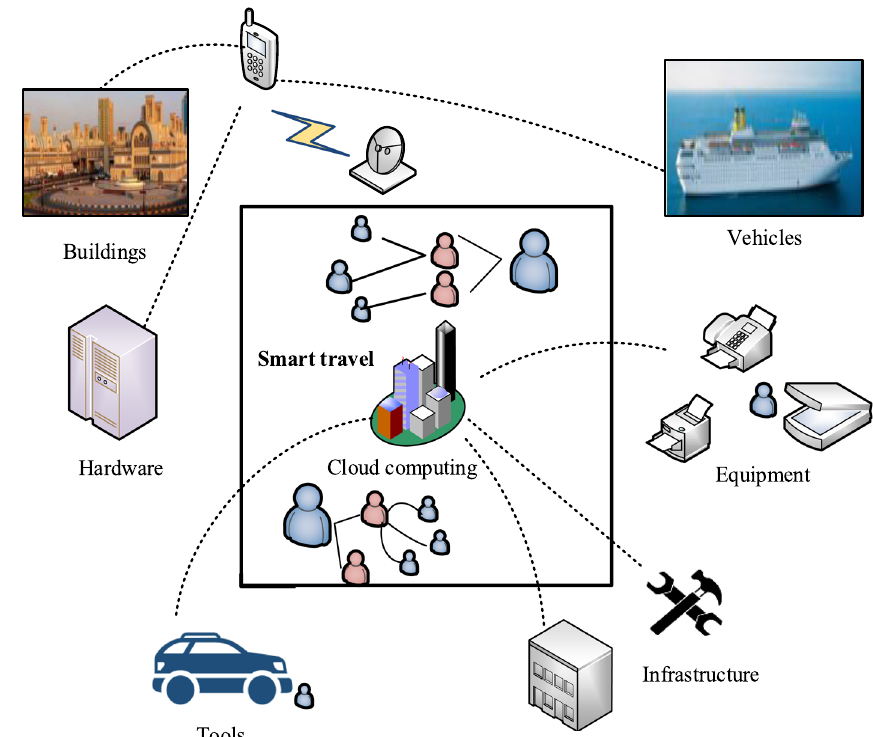
Fig. 3 Implementation of intelligent tourism